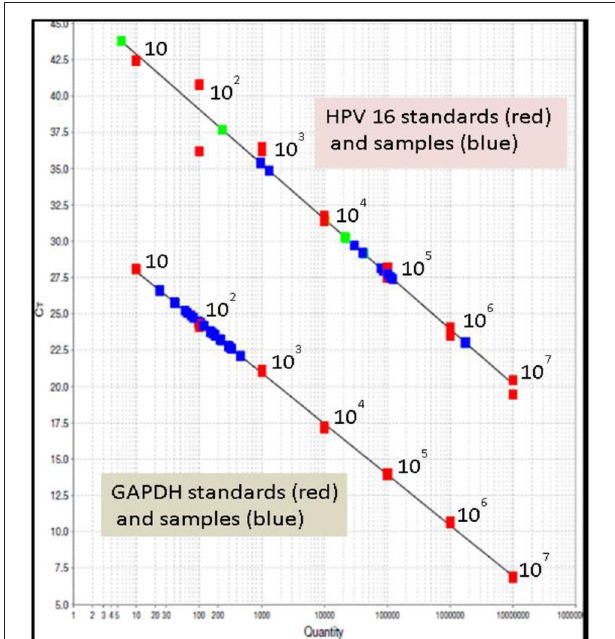
FIGURE 3 | Standard curve for HPV-16 viral load quantitation; upper line in the graph shows HPV-16 standards (red), HPV-16 samples (blue). The lower line in the graph shows glyceraldehyde-3-phosphate dehydrogenase (GAPDH) standards (red) and samples (blue). All in duplicate. Seen clustering in the range of 10–10 3 is sample GAPDH, a housekeeping gene for normalizing the results; shown in green are the known positive samples, run as controls.